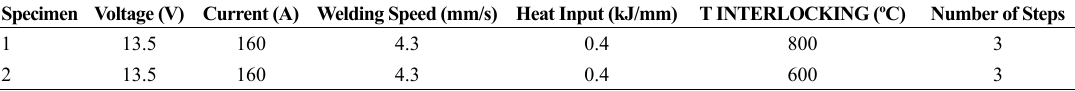
Table 3. Parameters of the final welding used in Stage 2, considering the efficiency of the process equal to